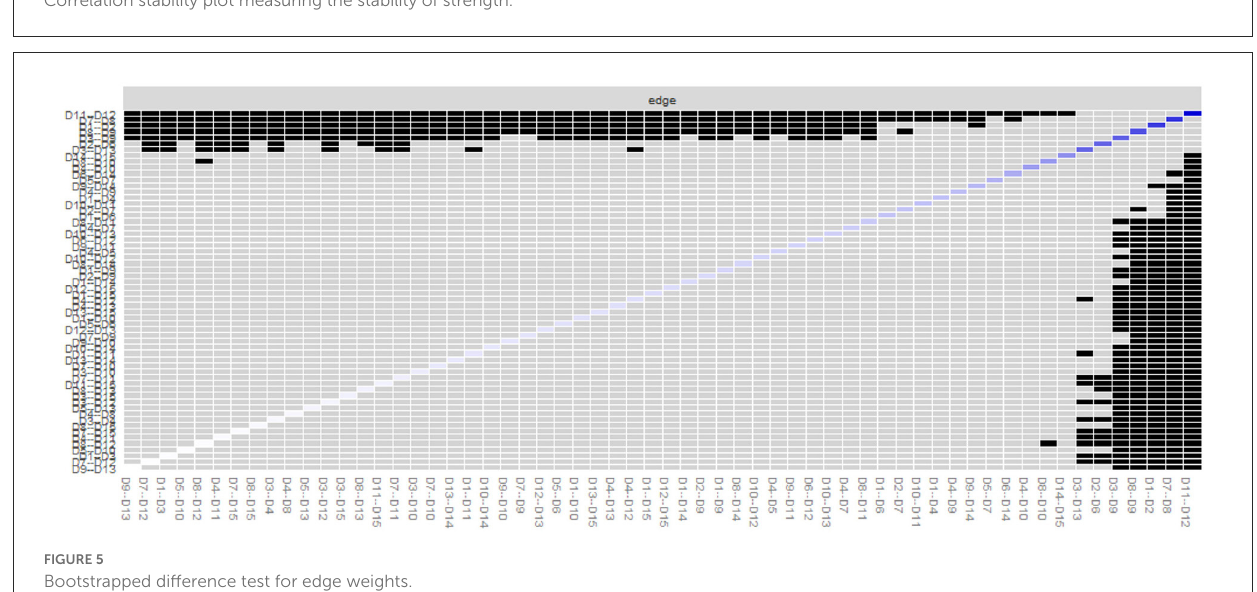
FIGURE4 Correlation stability plot measuring the stability of strength.